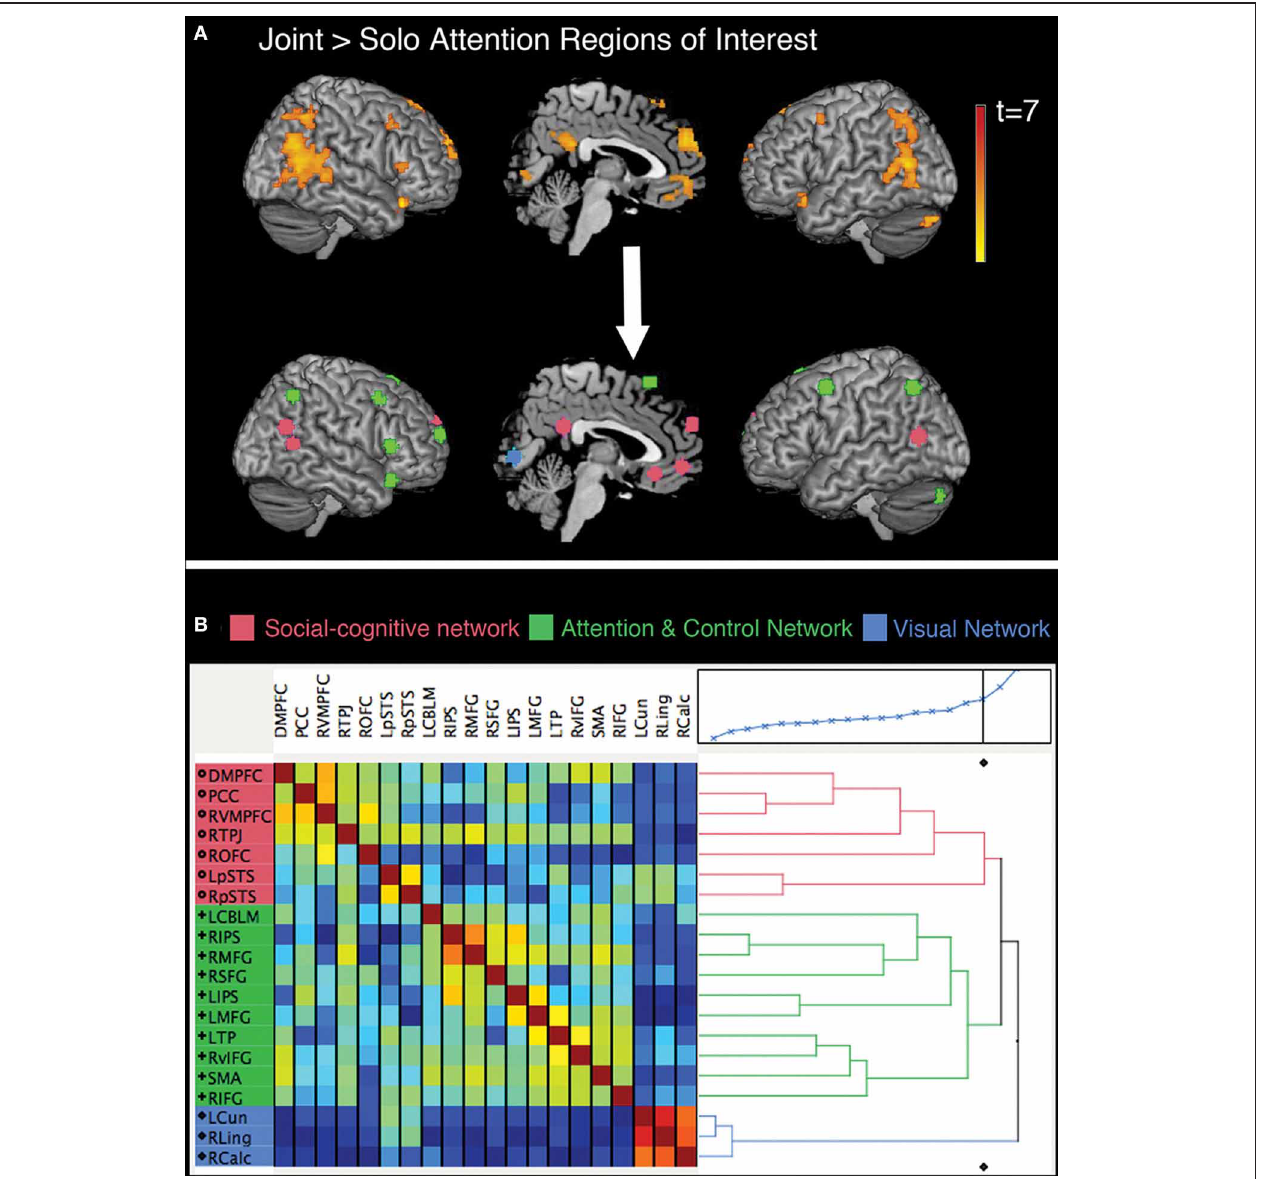
FIGURE 5 | Regions identified in the JA > SA contrast ( p < 0 . 001, cluster-corrected p < 0 . 05) are displayed on a reference brain in (A). Spheres surrounding the peak coordinates from each region were used as seed regions in the connectivity analyses. These spheres are shown on a reference brain color-coded by the cluster in which they were identified. Clusters are labeled social-cognitive (pink), attention and control (green), and